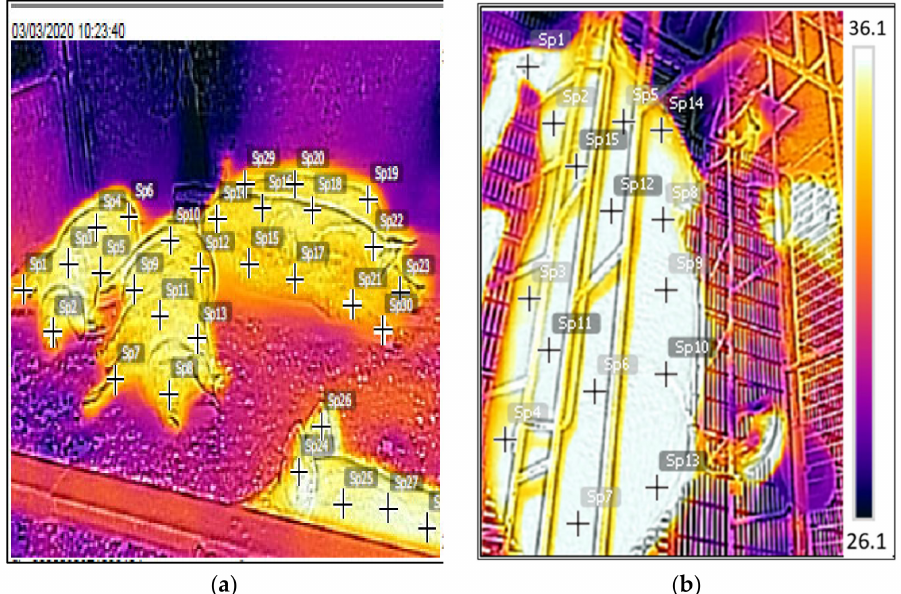
Figure 1. ( a ) Thermographic image of sows in collective gestation, ( b ) thermographic image of a lactating